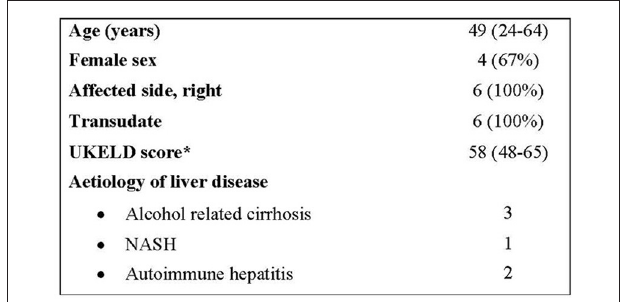
FIGURE 1 | Demographics. *A United kingdom Model for End-Stage Liver Disease (UKELD) score of 49 indicates a 9% 1-year risk of mortality, and a score of 60 indicates a 50% chance of 1-year survival